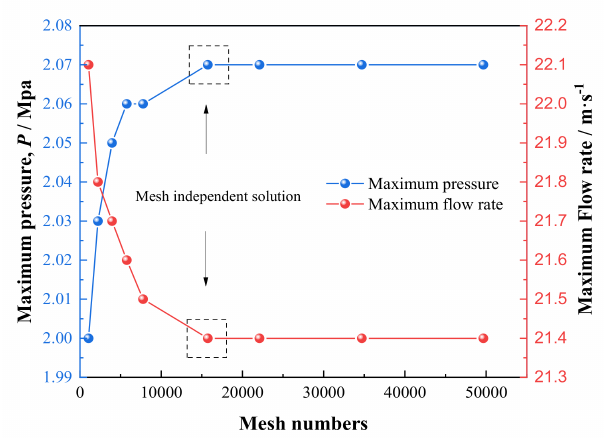
Figure 4. Mesh independence